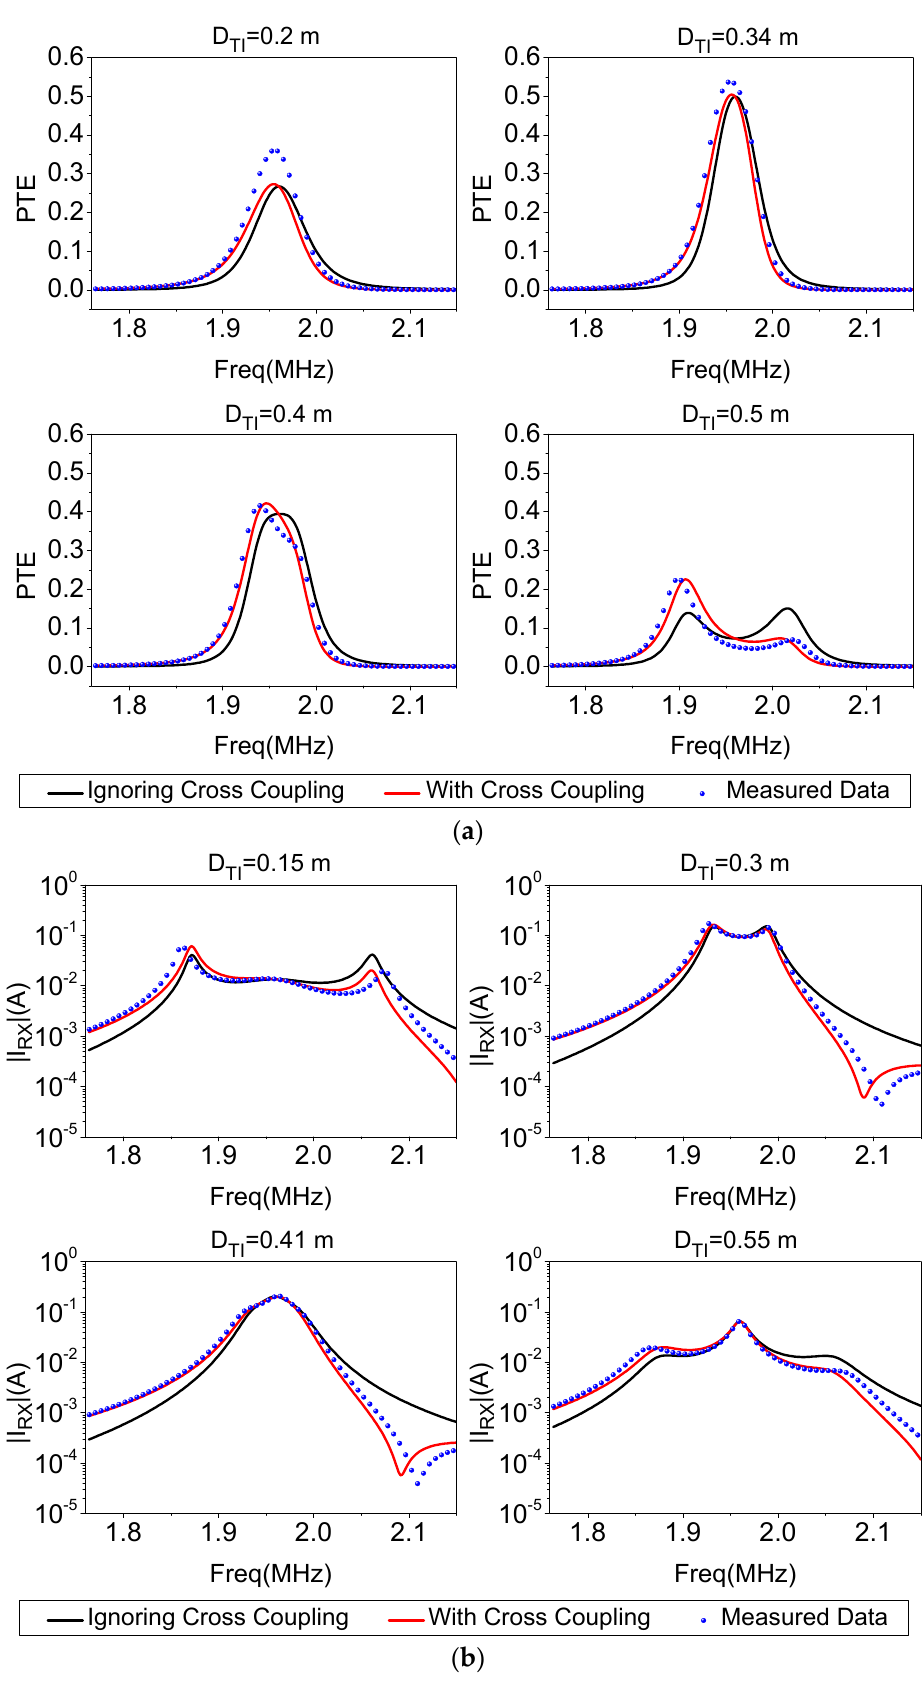
Figure 10. Measured and theoretical results of three ‐ resonator WPT system under collinear axes arrangement scenario at different inserted distance, D TI , when transfer distance D TR = 0.7 m: ( a ) PTE vs. frequency; and ( b ) | I RX | vs.